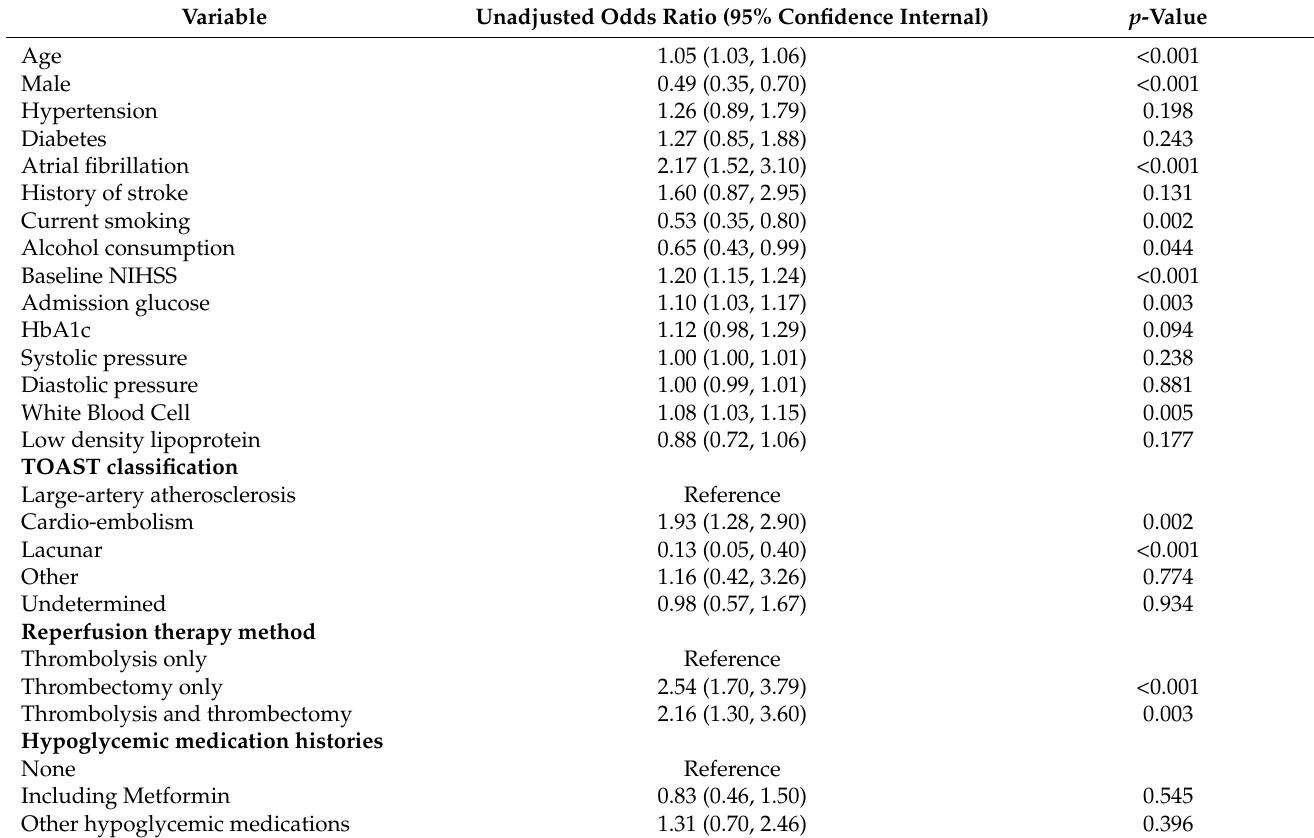
Table 2. Univariable logistic regression analysis of factors associated with 3-month unfavorable outcome.